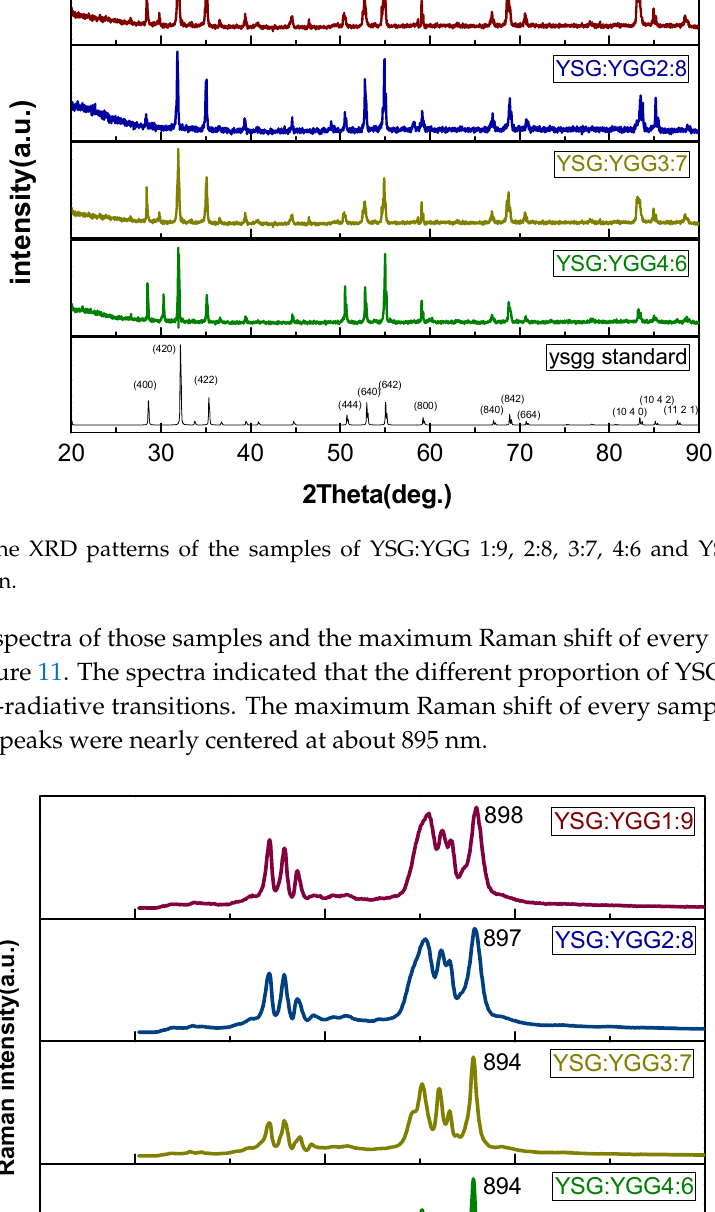
8 of 10 Figure 8. Decay curves of Er 3+ : 4 I 13/2 levels in samples of YSG:YGG 1:9, 2:8 and 4:6. . Figure 9. Decay curves of Er 3+ : 4 I 11/2 levels in samples of YSG:YGG 3:7. 3.3. XRD and Raman Analyses Figure 10 shows the XRD patterns of every samples and YSGG standard for comparison. All samples showed a consistent pattern of YSGG. Therefore, the mixed crystals of YGG and YSG did not cause a change in the crystal phase, and they all maintained the structural characteristics of the